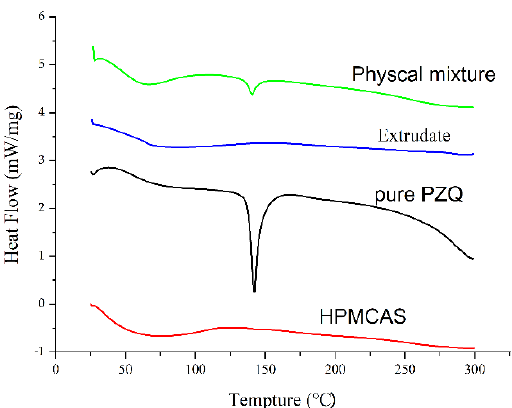
Figure 2. DSC thermograms of pure PZQ, a physical mixture, extrudate and HPMCAS.